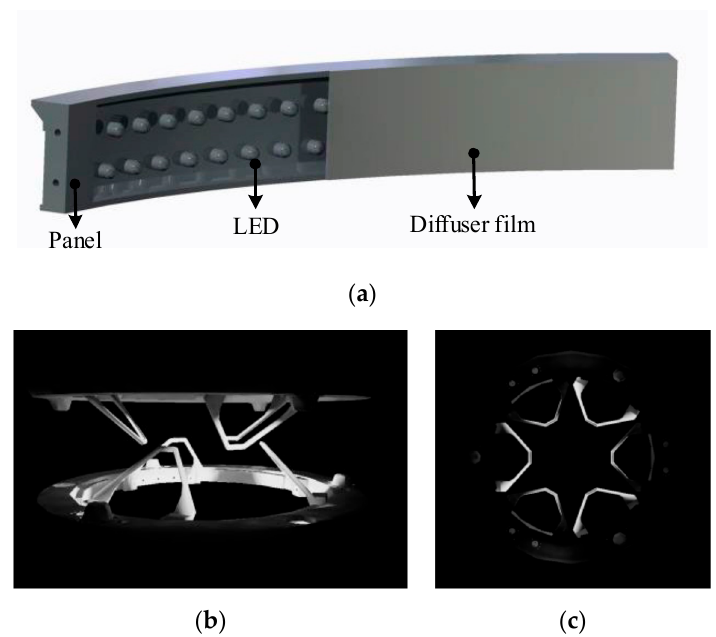
Figure 4. Active light source. ( a ) The internal structure of the arc-shaped light-emitting diode (LED) panel. ( b ) A rendering of the active light source (front view). ( c ) A rendering of the active light source (side view).